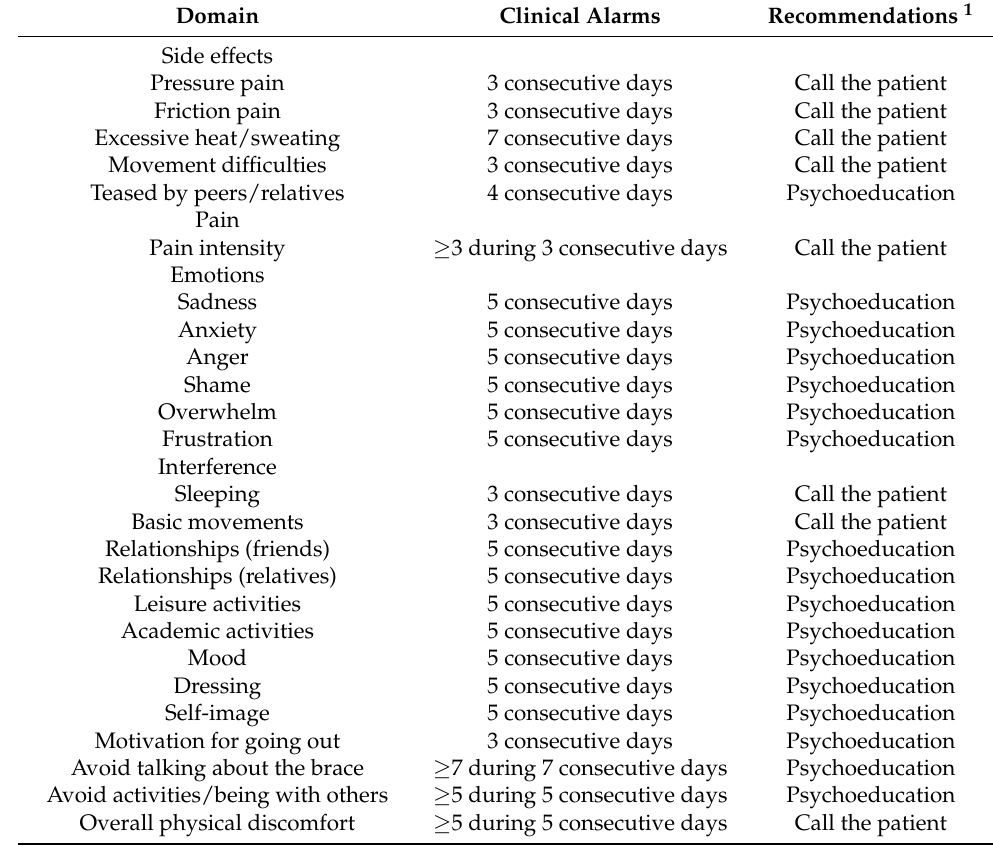
Table 1. Pre-specified clinical alarms detected by the mobile